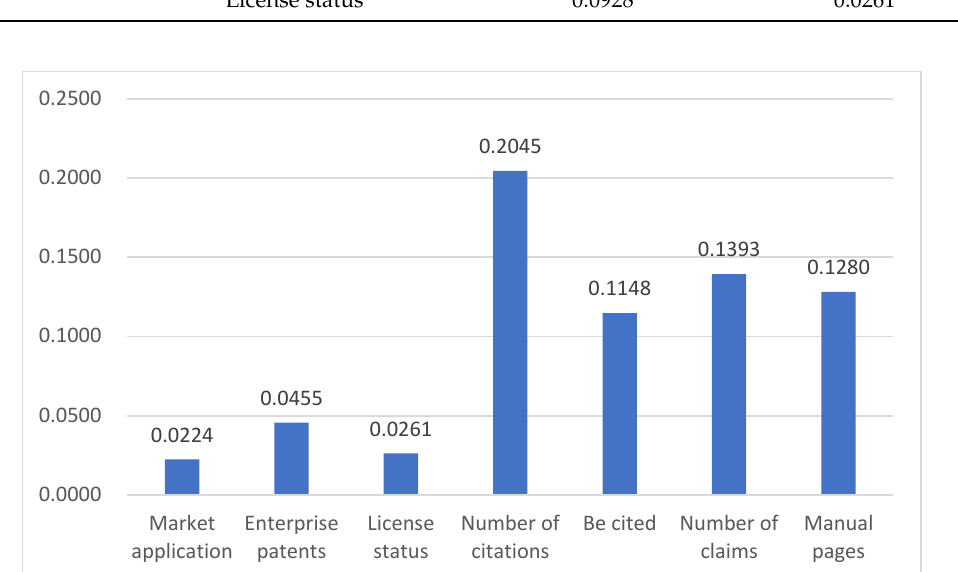
Figure 4. The top four and bottom three attributes and their weights in the weight vector.